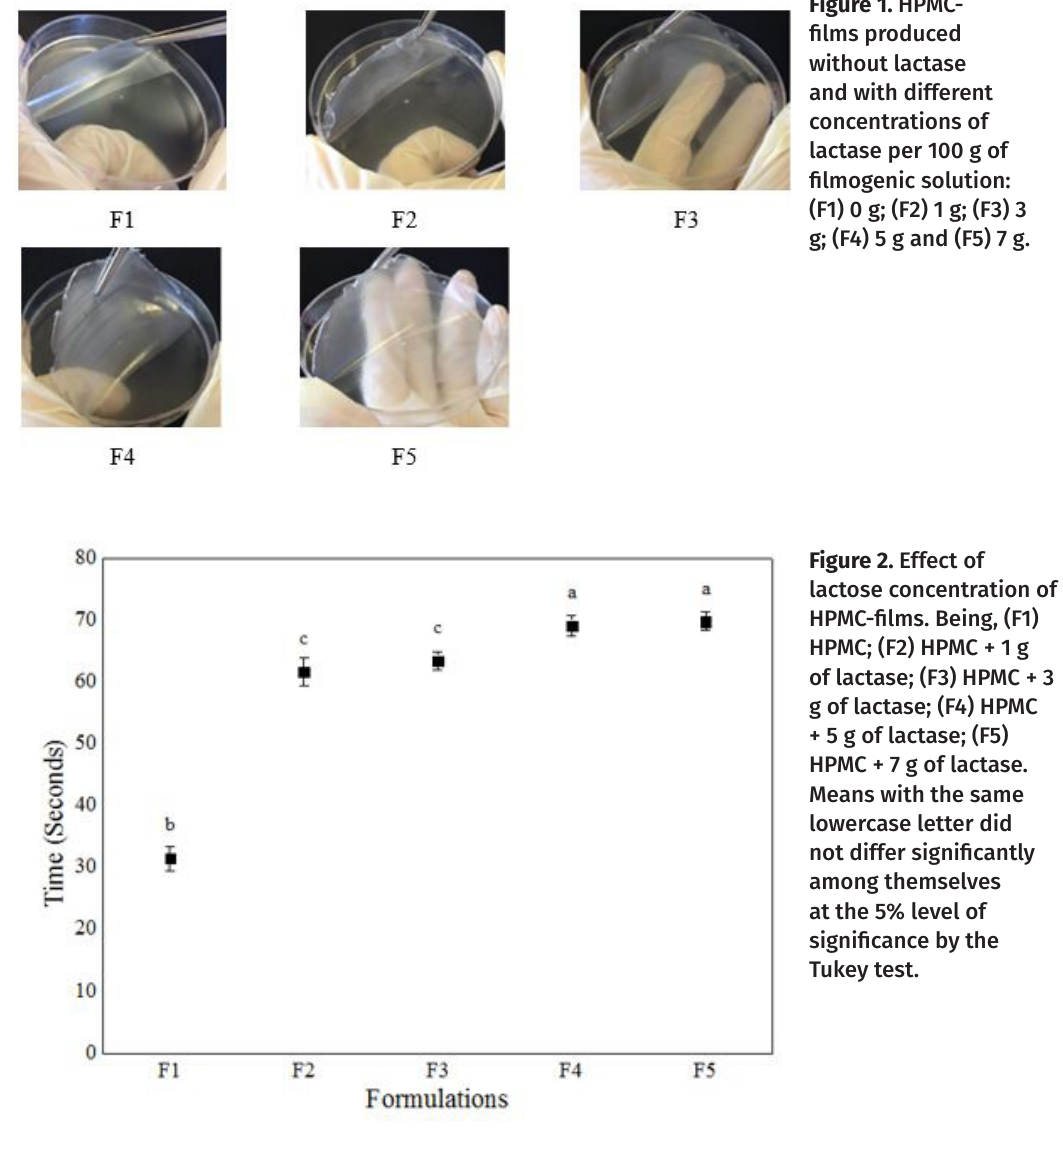
Table II. Determination of lactose content in whole milk.